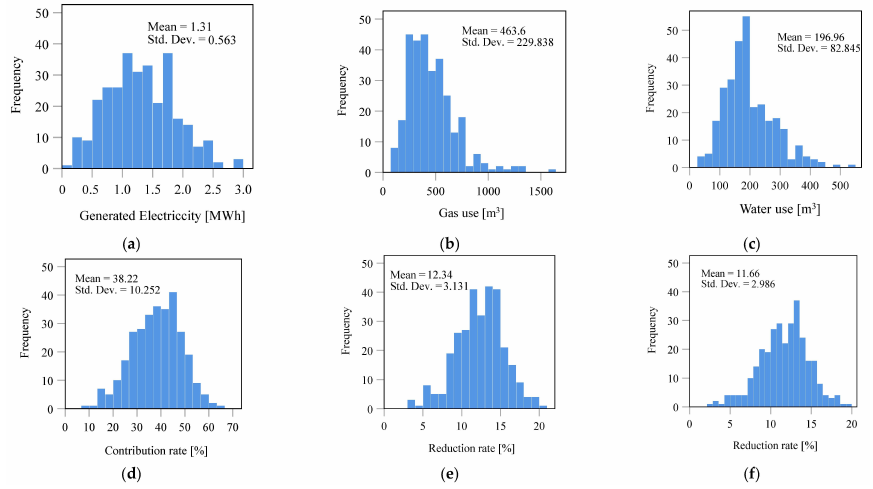
Figure 2. Annual distribution (n = 304): ( a ) electricity generation; ( b ) gas use (except for CGS); ( c ) water use; ( d ) contribution rate; ( e ) reduction rate of primary energy consumption; ( f ) reduction rate of CO 2